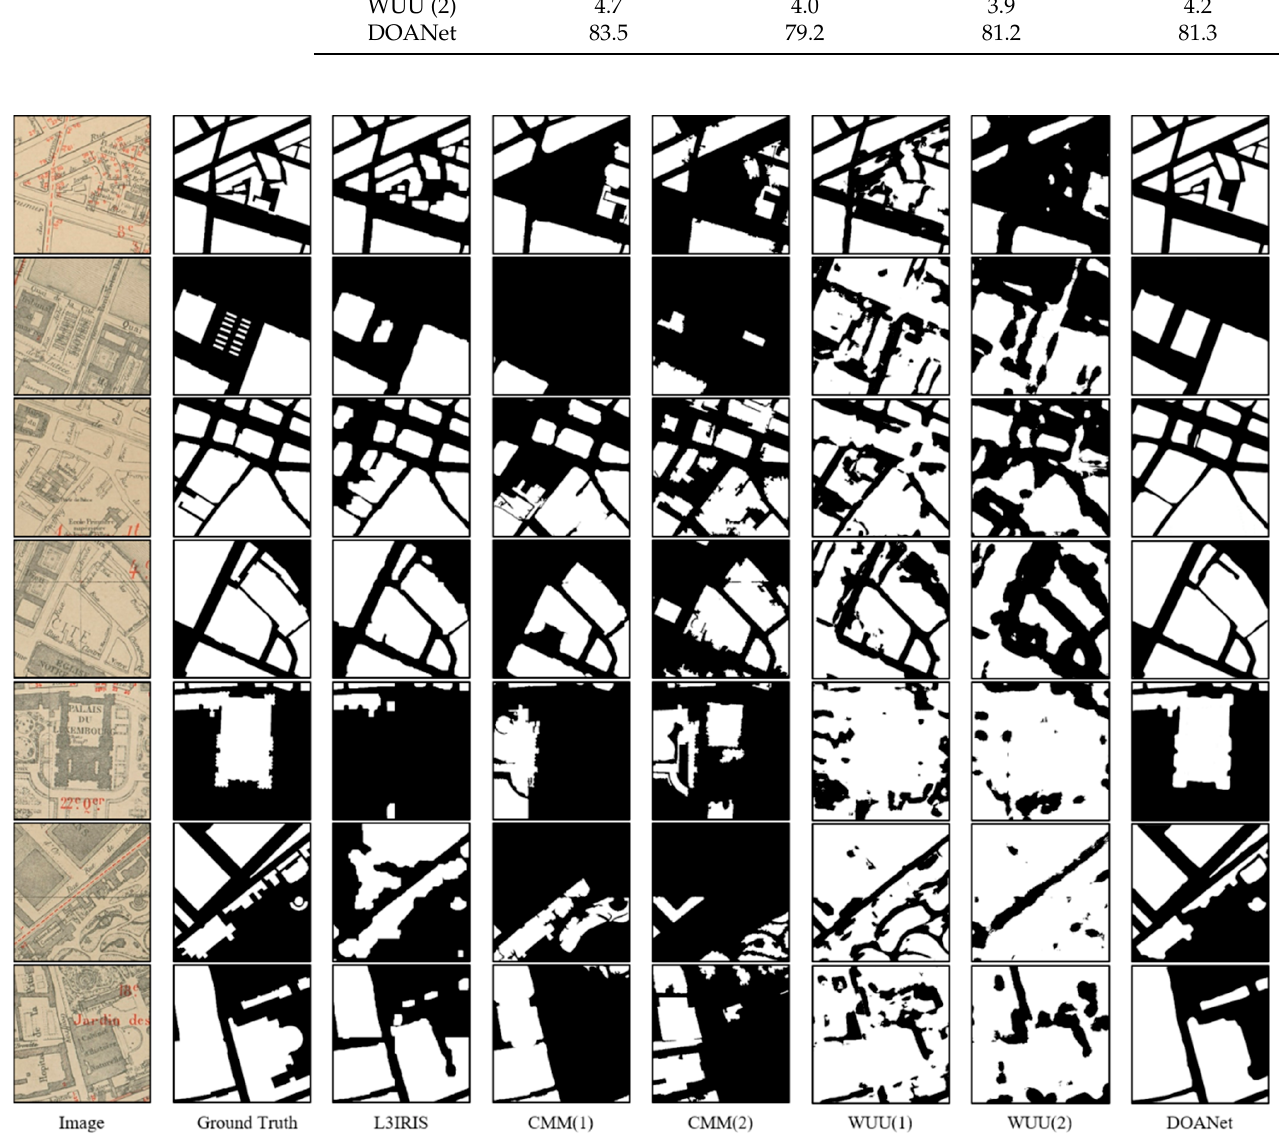
Figure 7. Sample results of the building block (white) extraction.